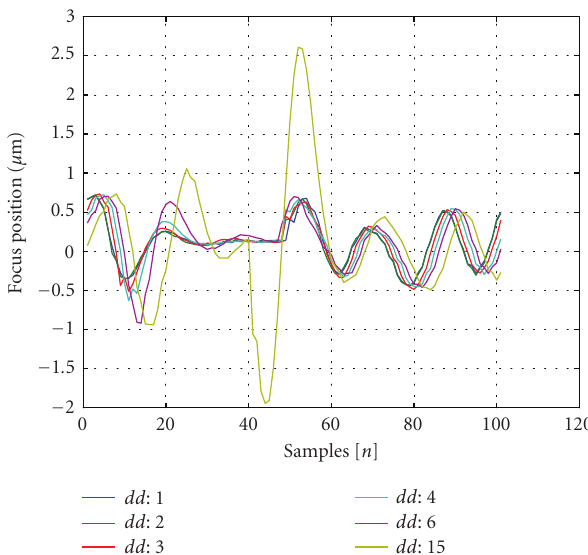
Figure 11: Simulation of the e ff ect of detection delays on the closed loop focus